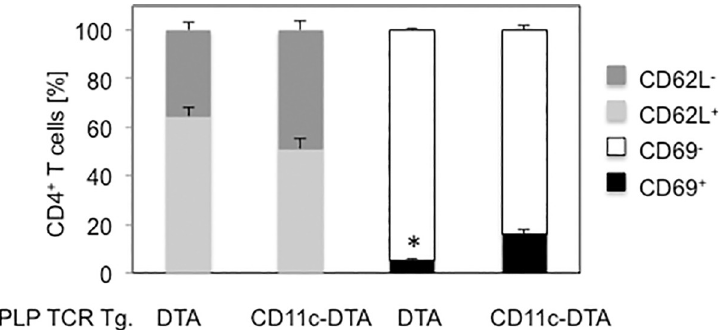
Fig 5. Increased frequencies of primed CD4 + T cells in PLP TCR Tg. CD11c-DTA SJL mice. Frequencies of early activated (CD69 + ), effector memory (CD62L - ) cells or unprimed cells (CD69 - , CD62L + ) in splenic CD4 + T cells from 5–8 week old PLP TCR transgenic CD11c-DTA SJL mice (n = 4) or PLP TCR Tg. DTA control mice (n = 3) were determined by flow cytometry. Data are shown as mean cell frequencies (%) ± SEM of four independent